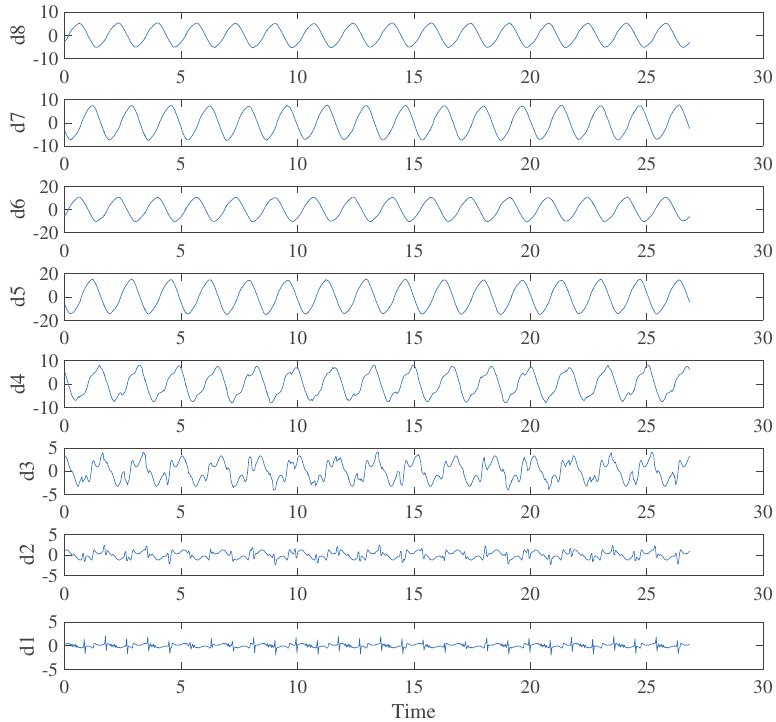
frequency is 0.6 Hz.